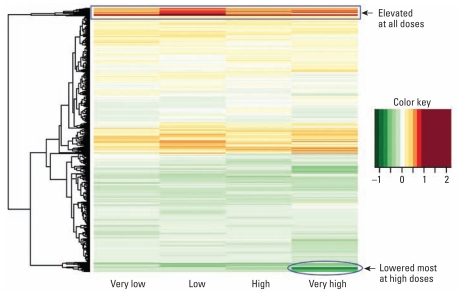
Dose-dependent effects on gene expression. A heat map illustrates simple hierarchical clustering of the differentially expressed 3,007 probes (FDR-adjusted p-value < 0.05) based on the mixed model described in “Materials and Methods.” The clustering was done on the four log2 expression ratios (derived as coefficients returned from the mixed model) all relative to controls. The color key relates to the log2 ratios observed. Clustering of genes was based on complete linkage (for algorithmic details of algorithms used, see Murtagh 1985), as implemented in the hclust function in R, called by the heatmap.2 function available with the gplots library in Bioconductor (Gentleman et al. 2004). Note that the clustering is based on Euclidean distance.